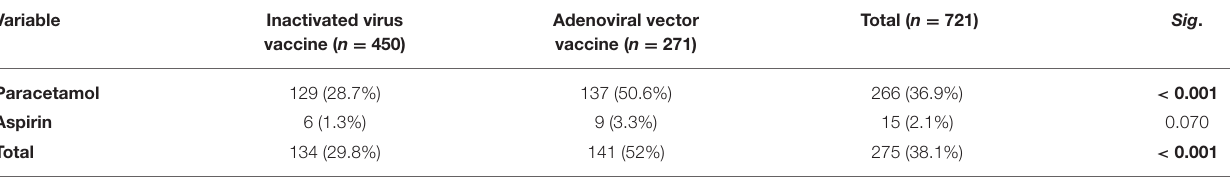
TABLE 5 | Post-vaccination medications received by Algerian healthcare workers ( n = 721).